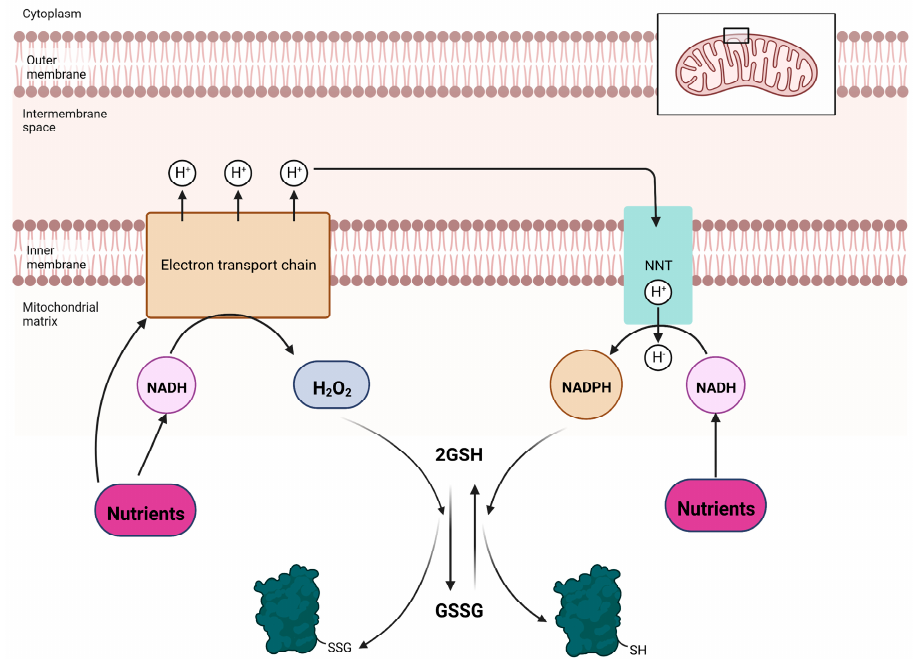
Figure 2. Reversible glutathionylation reactions in mitochondria are intimately linked to oxido-re- duction reactions that drive nutrient oxidation and NADPH production. Oxidation of nutrients